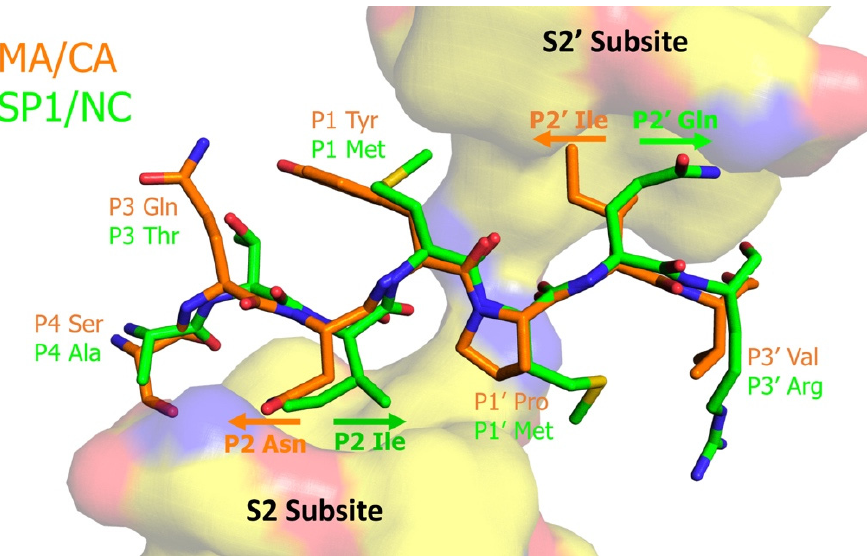
Figure 6. Structural Interpretation of Substrate Orientation Within the HIV-1 Protease with and without a P1’ Proline. The surfaces of the viral protease are shown for the S2 and the S2’ subsites with yellow as hydrophobic, blue as positive charge, and red as negative charge. Two substrates are superimposed in stick figure with MA/CA in orange and SP1/NC in green. The individual substrate amino acids are indicated, with arrows showing the differing orientations of the P2 and P2’ side chains in the substrate. The structures are from ref. [80], and the figure was constructed in PyMol using PDB files 1KJ4 and 1KJ7.